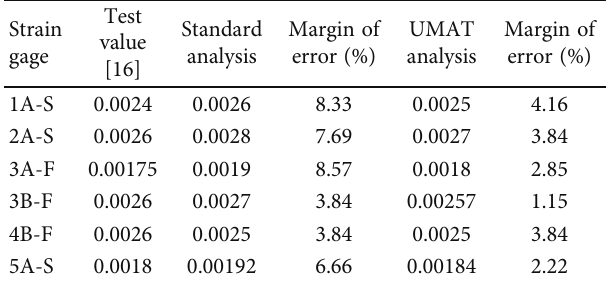
Table 6: Comparison of strain-load results in the simulated gages.